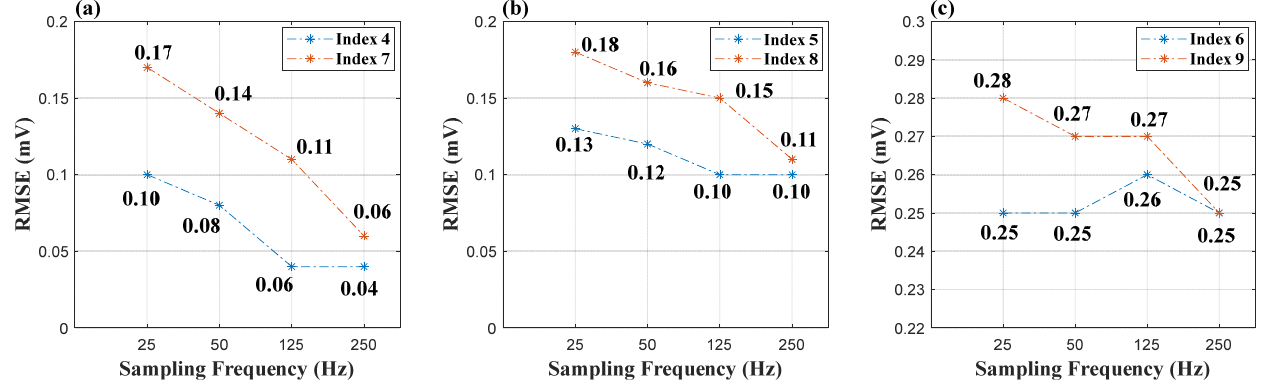
Figure 8. ( a ) RMSE of Indices 4 and 7 ( b ) RMSE of Indices 5 and 8 ( c ) RMSE of Indices 6 and 9.